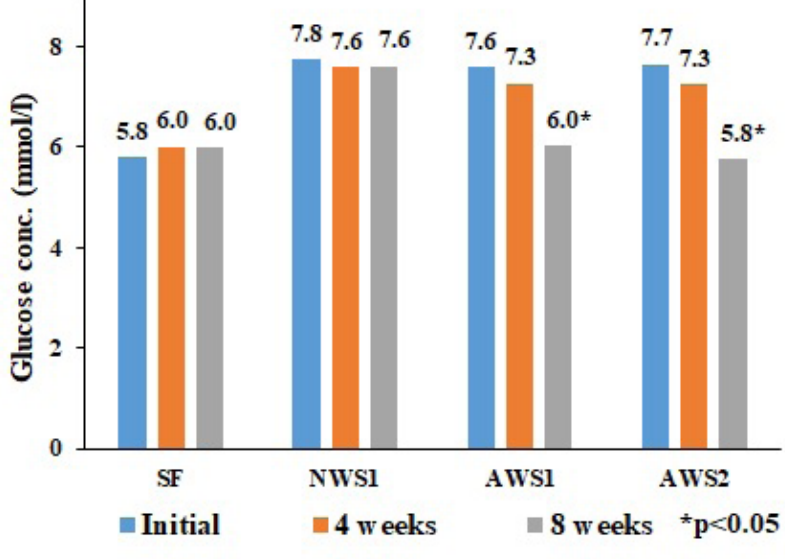
FIGURE 3 - Glucose concentrations of four experimental mice groups after 8